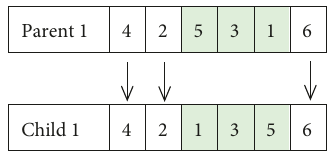
Figure 6: GA inver-over